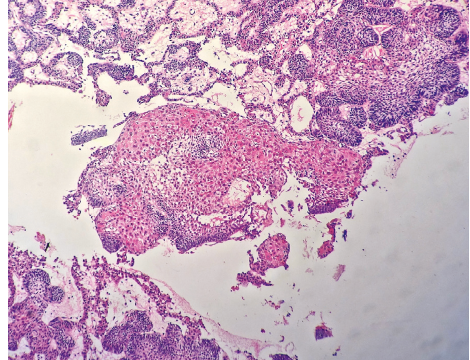
Figure 3: Photomicrograph showing odontogenic epithelial is- lands arranged in follicles within the connective tissue stroma (H&E 10x view).